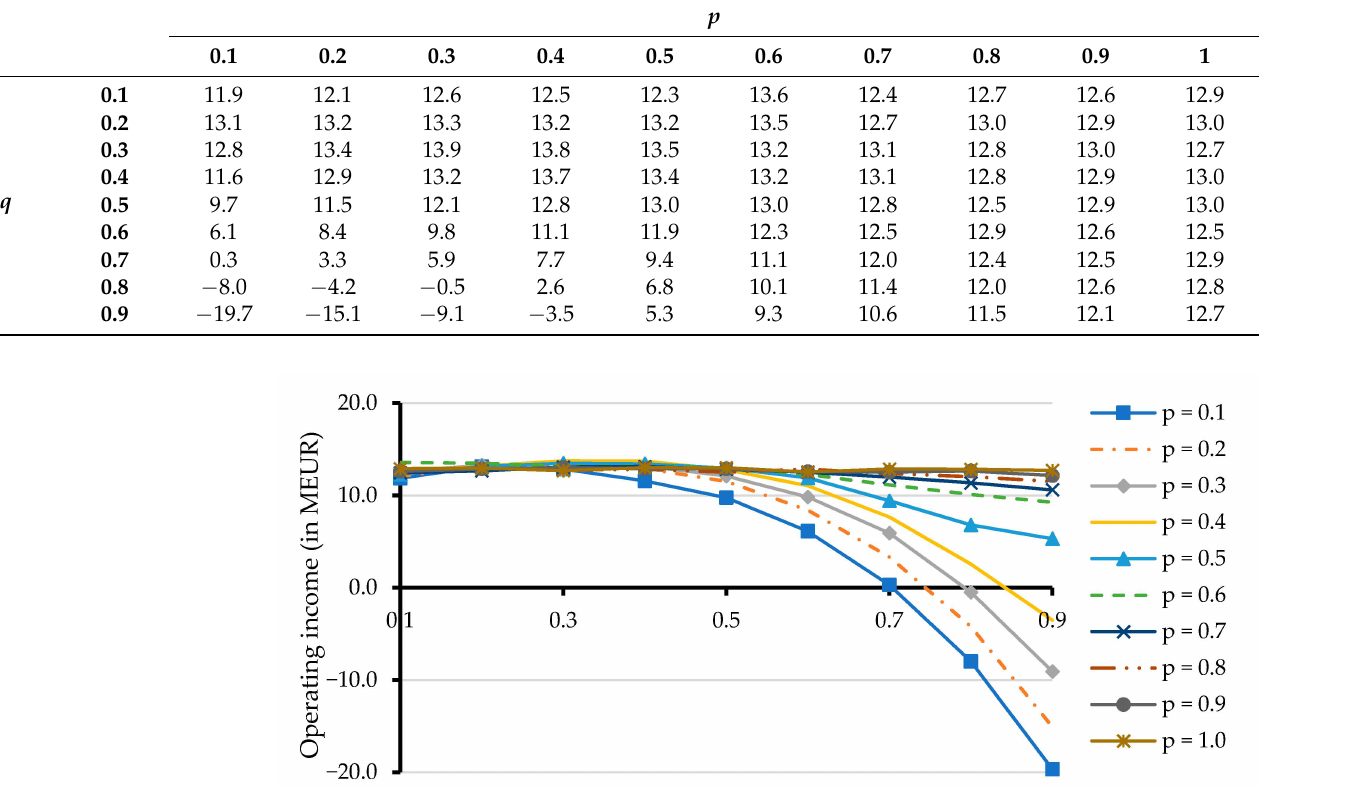
Table 13. Operating income for different q and p (in MEUR). Matrix representation.